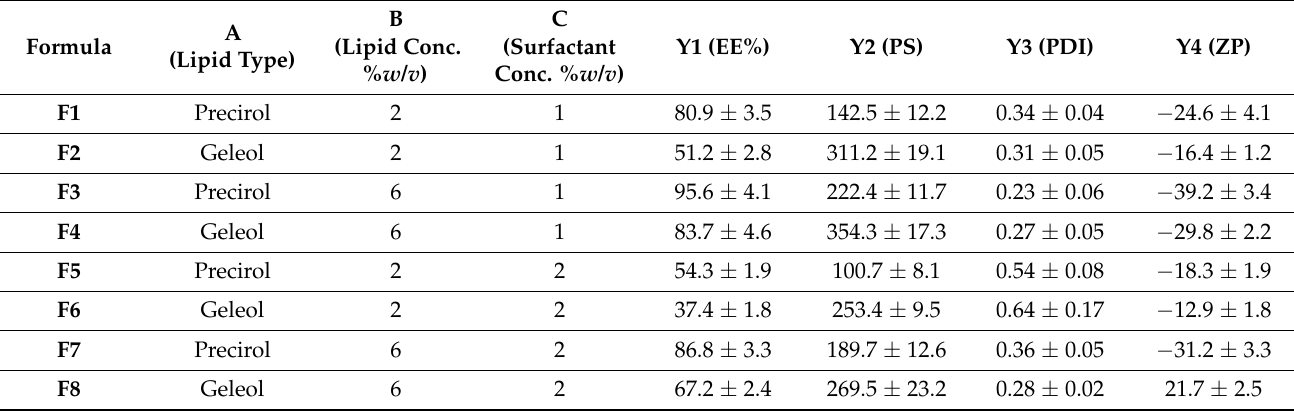
Table 2. Experimental runs, independent variables, and estimated responses of 4h -loaded NLCs via 2 3 full factorial